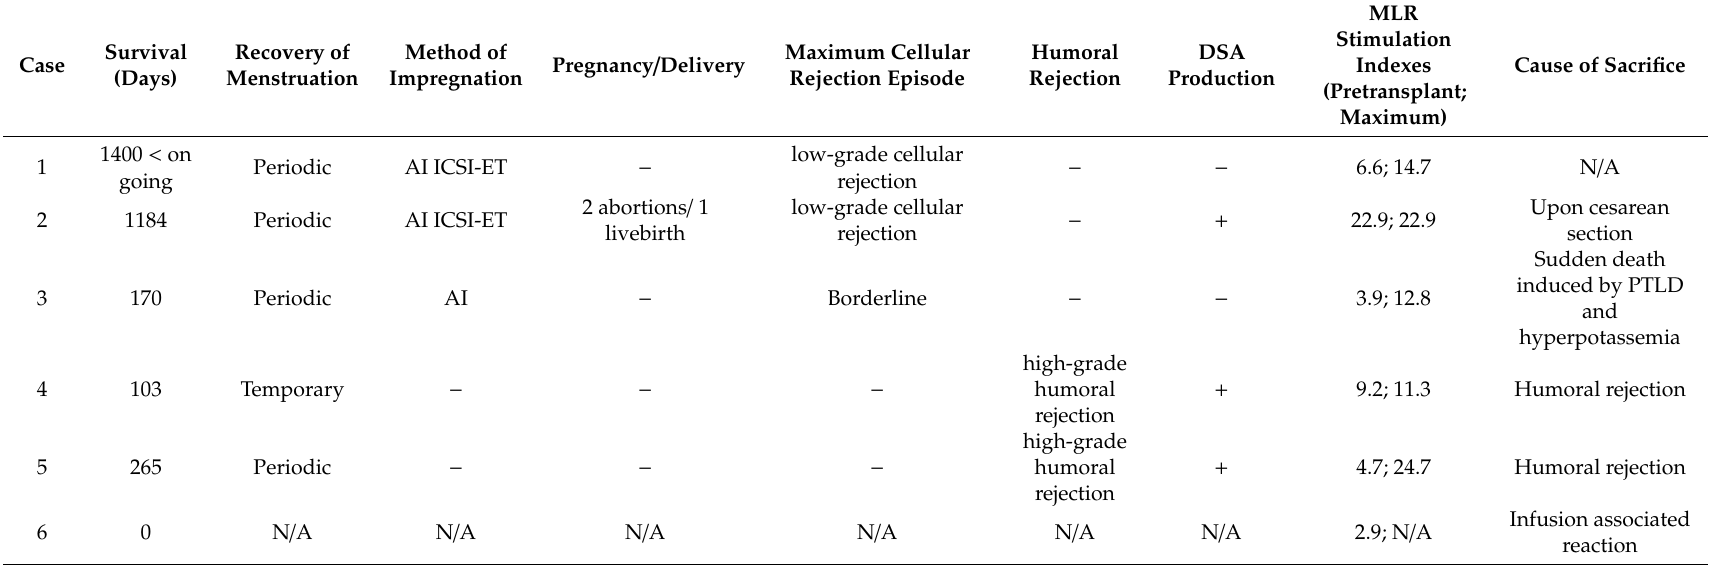
Table 5. Outcomes of clinical course in